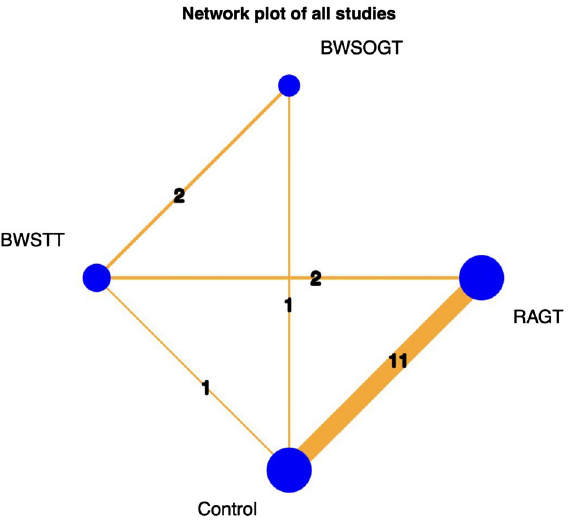
Figure 3. Network plot of all studies. The nodes, which represent the interventions in the network, and the lines, which highlight the available direct comparisons between pairs of interventions. The size of the nodes and the width of the lines both represent the number of studies. RAGT, robot-assisted gait training; BWSTT, body weight-supported treadmill training; BWSOGT, body weight-supported overground training.